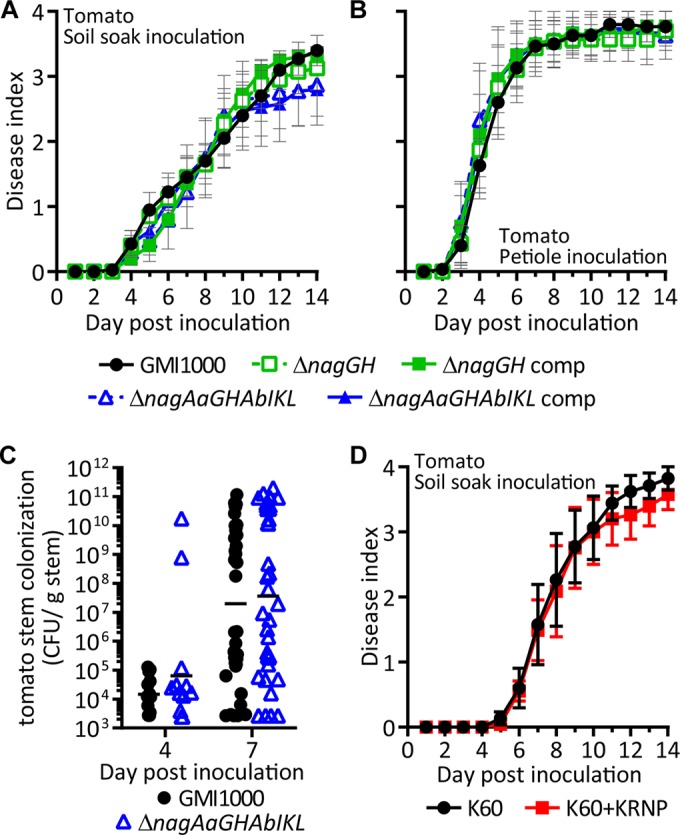
The Nag pathway does not contribute to virulence of R. solanacearum on tomato. (A) Seventeen-day-old tomato plants with unwounded roots were soil soak inoculated by pouring bacterial suspensions into the pots (1 × 108 CFU/g soil). Symptoms were rated on a 0 to 4 disease index scale corresponding to the percentage of wilted leaves. (B) Twenty-one-day-old tomato plants were petiole inoculated by placing a suspension of 500 cells on a freshly cut branch. (C) Bacterial density in stem tissue was quantified by dilution plating stem tissue from soil soak inoculated plants. Each symbol represents the population size in a single plant, and horizontal lines represent the geometric means. (D) Seventeen-day-old tomato plants with unwounded roots were soil soak inoculated with SA-degrading strain K60+KRNP or the isogenic strain that does not degrade SA (K60). Virulence of strains (A, B, and D) were not significantly different (P > 0.05; repeated measures ANOVA). Bacterial populations in tomato stem (B) were not significantly different (P > 0.05 at 4 and 7 days post-soil soak inoculation; Mann-Whitney test).